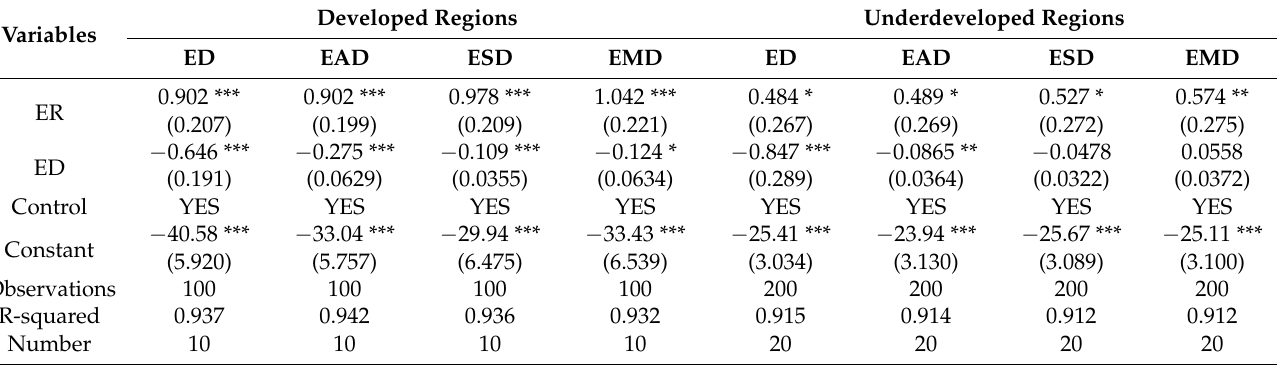
Table 3. Regional level regression